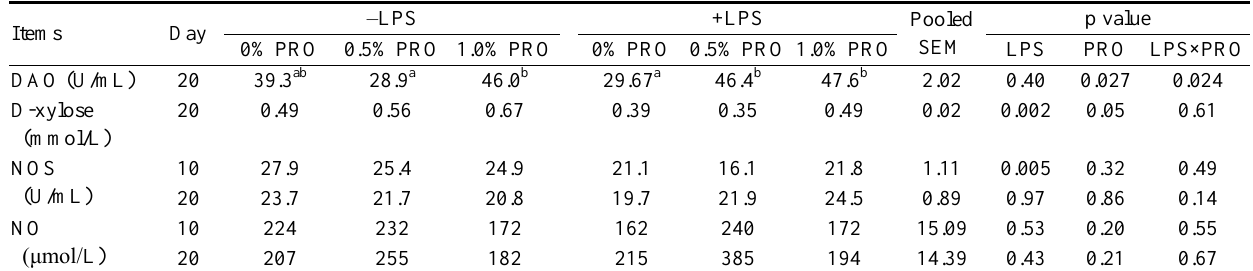
Table 7. Effects of L-proline supplementation on plasma D-xylose, DAO, NOx, and NOS concentration in weanling piglets after